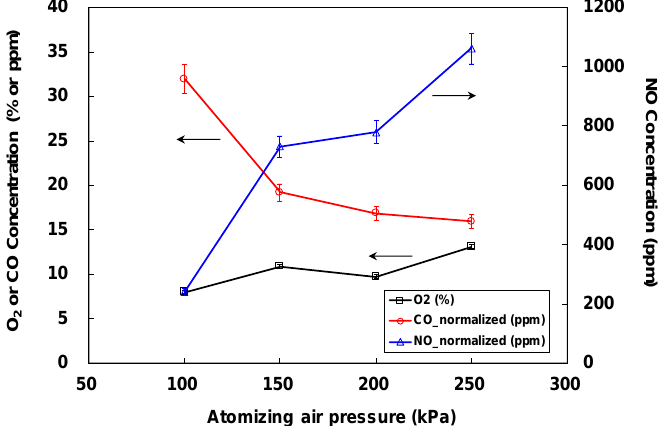
Figure 8. Temperature distributions for various swirl numbers at p = 150 kPa and ϕ = 0.8.